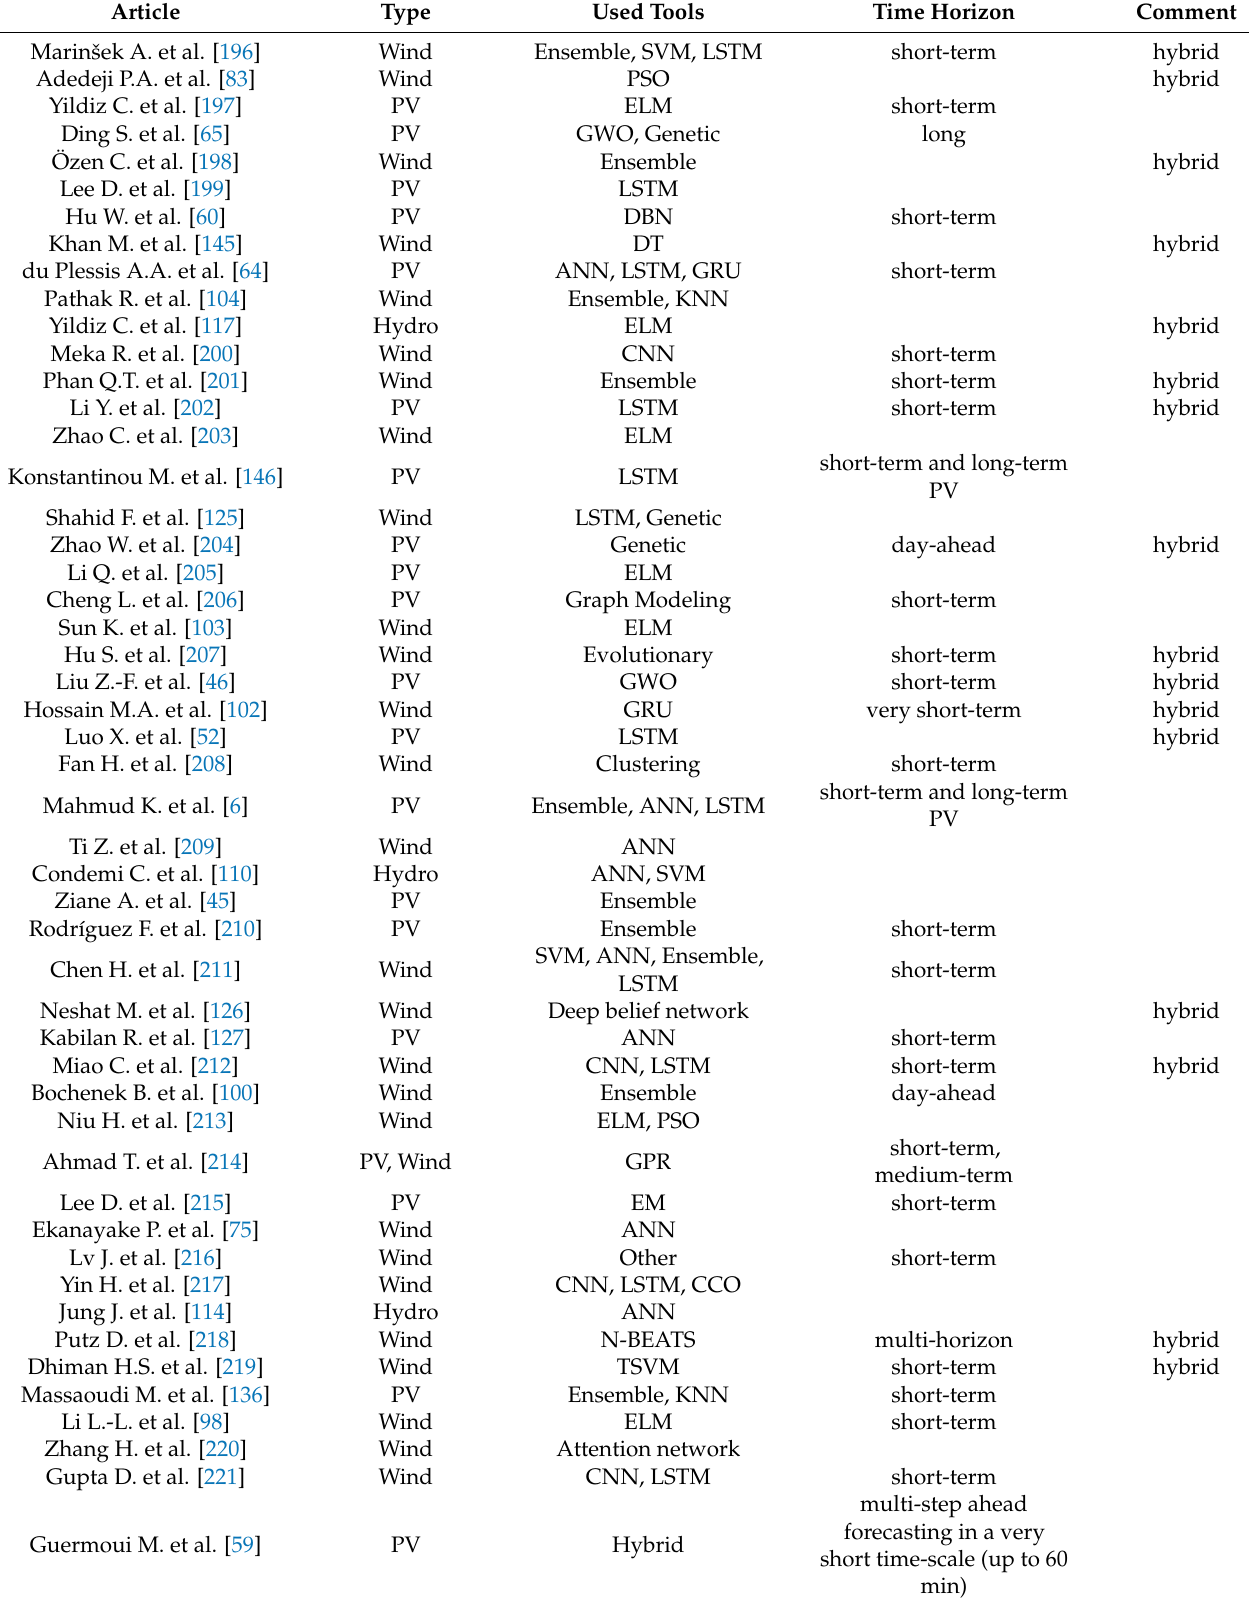
Table A2. An overview and comparative analysis of articles from